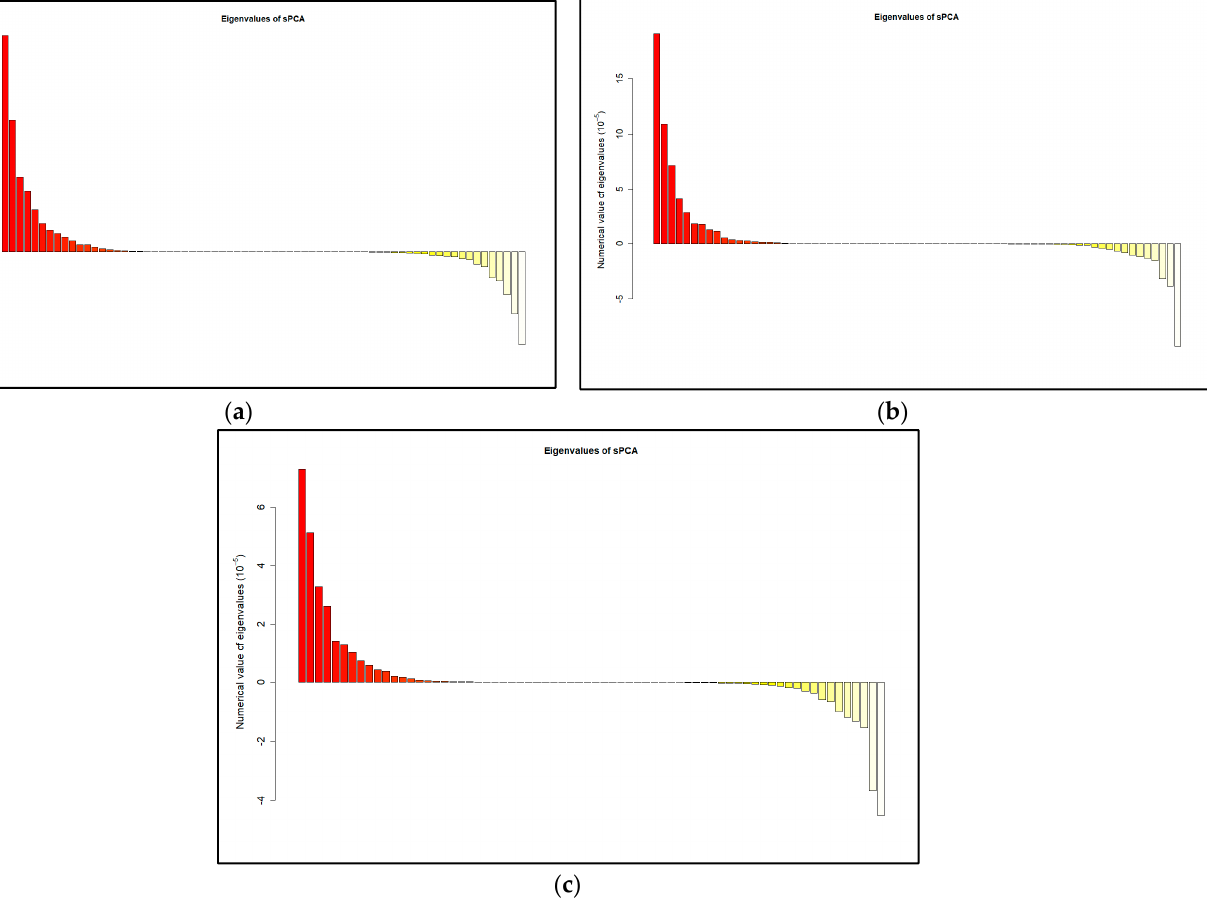
Figure A4. Distribution of eigenvalues based on FASPCA and Gabriel graph-based connection network: ( a ) period 1; ( b ) period 2; ( c ) period 3. Eigenvalues in red and yellow correspond to positive and negative eigenvalues respectively.